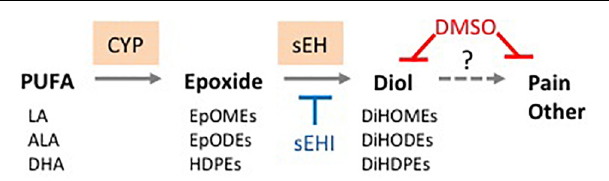
FIGURE 5 | Proposed basis for therapeutic effects of DMSO. DMSO directly reduces oxylipin diol levels in tissues and thus helps mitigate pain and other symptoms associated with diol accumulation. Solid line, known reaction; dashed line, proposed causal effect. sEHI, soluble epoxide hydrolase inhibitor. See text for